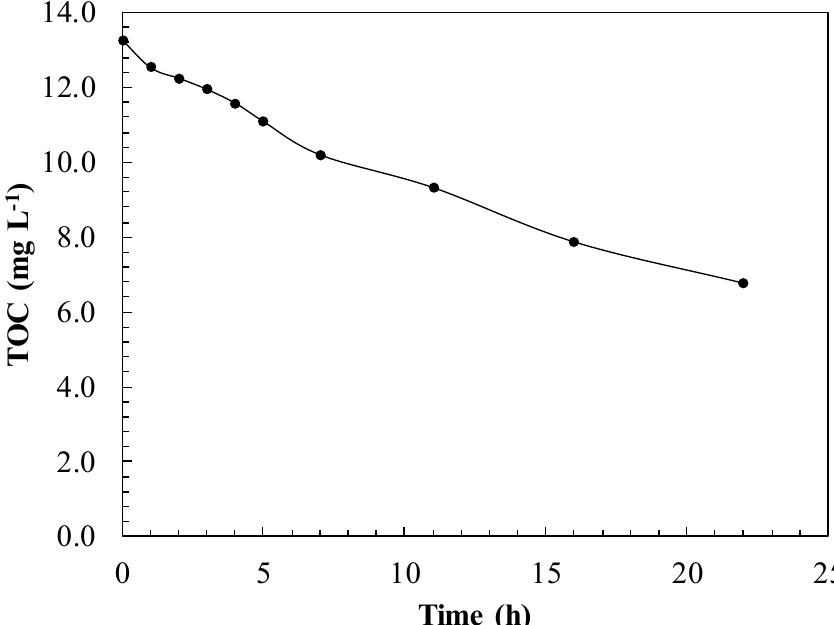
Figure 12. Photocatalytic oxidation of aniline and benzothiazole mixtures monitored by total organic carbon (TOC) with hybrid suspended-supported TiO 2 configuration. Experimental conditions: C 0 =